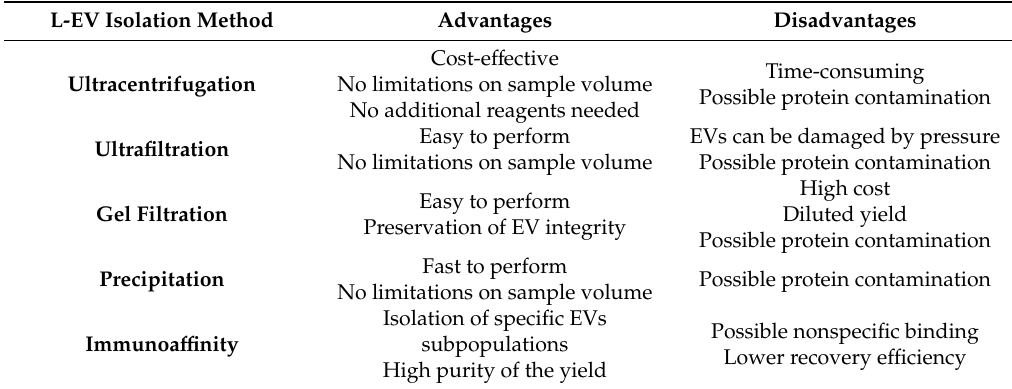
Table 1. Methods for L-EVs isolation in